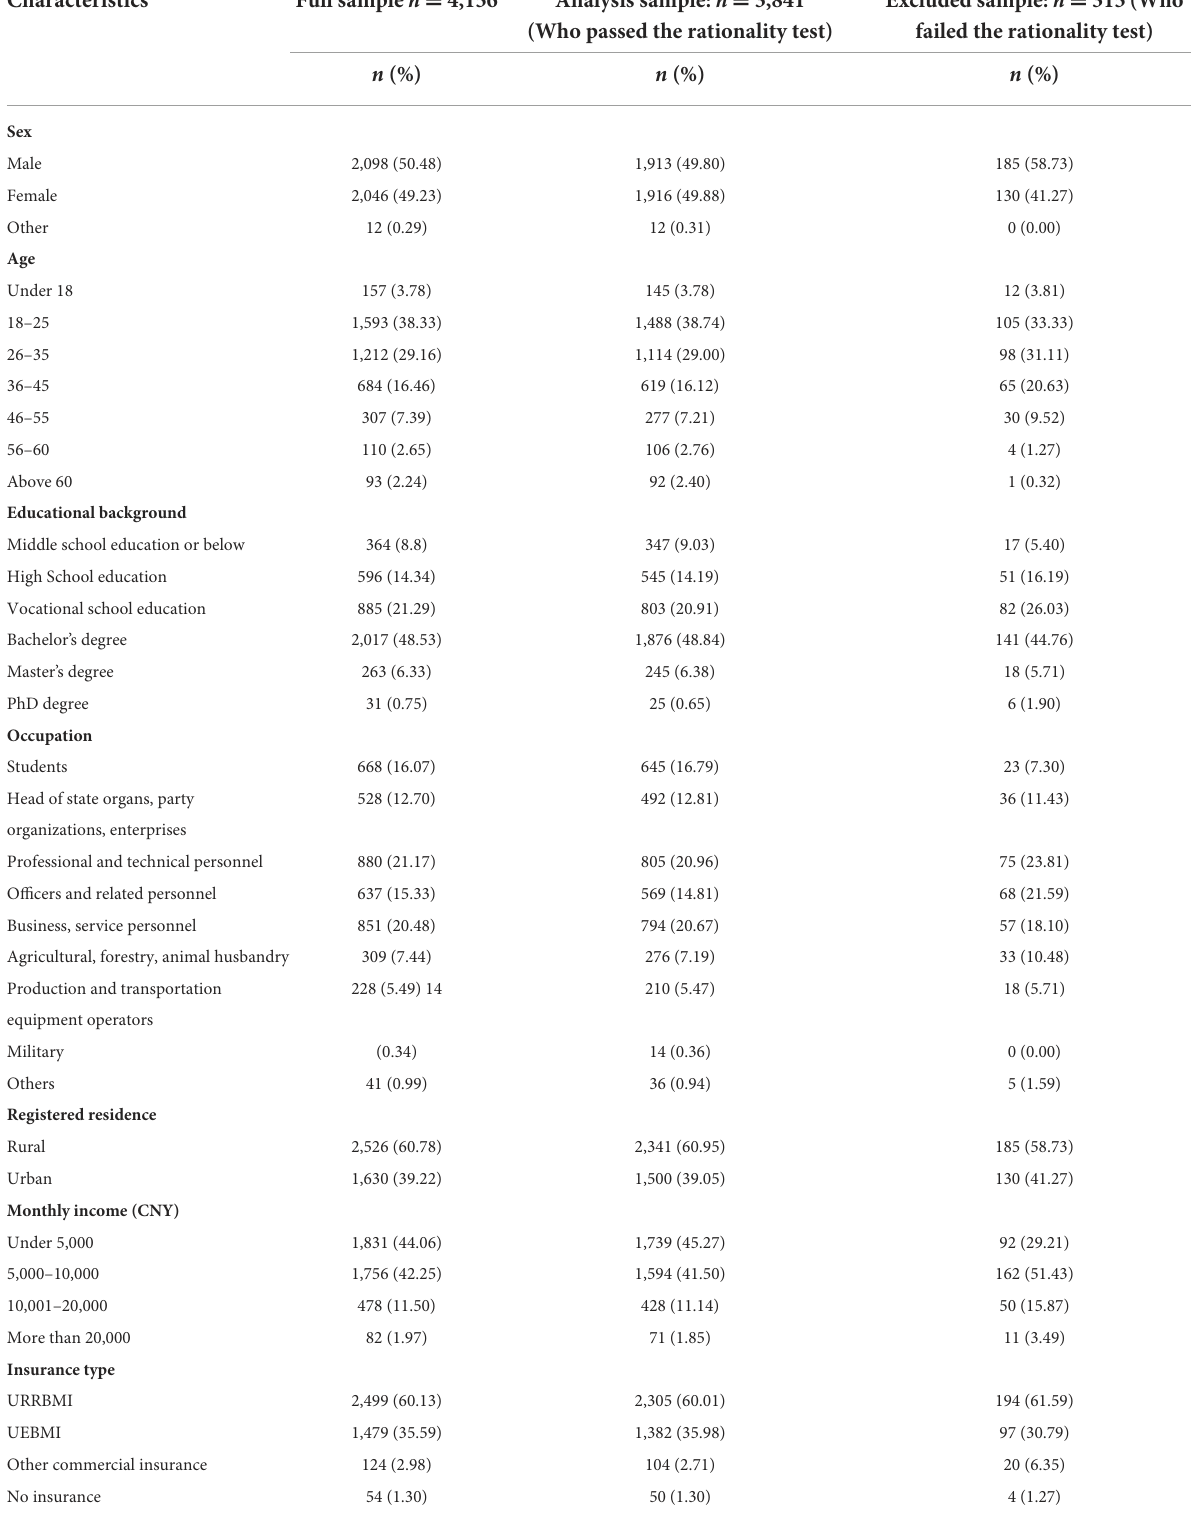
TABLE 3 Characteristics of the study